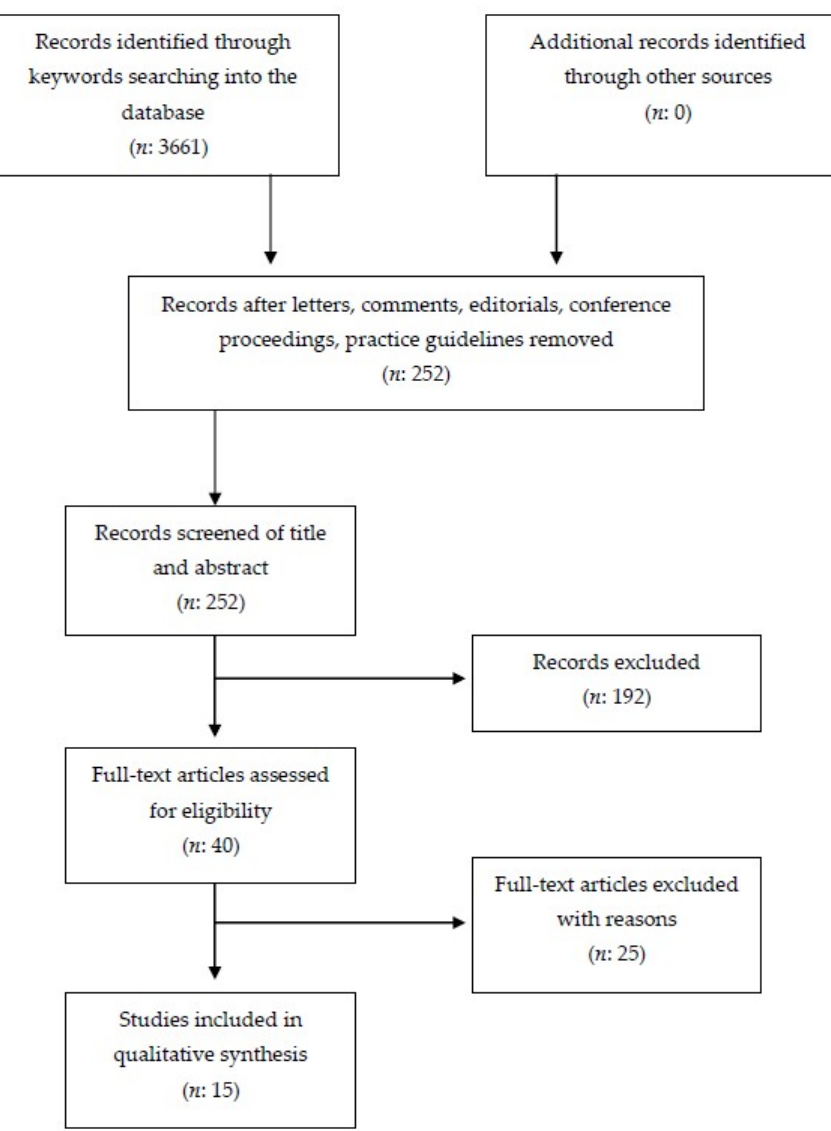
Figure 1. Preferred reporting items for systematic review and meta-analysis (PRISMA) flow chart concerning study retrieval and selection.